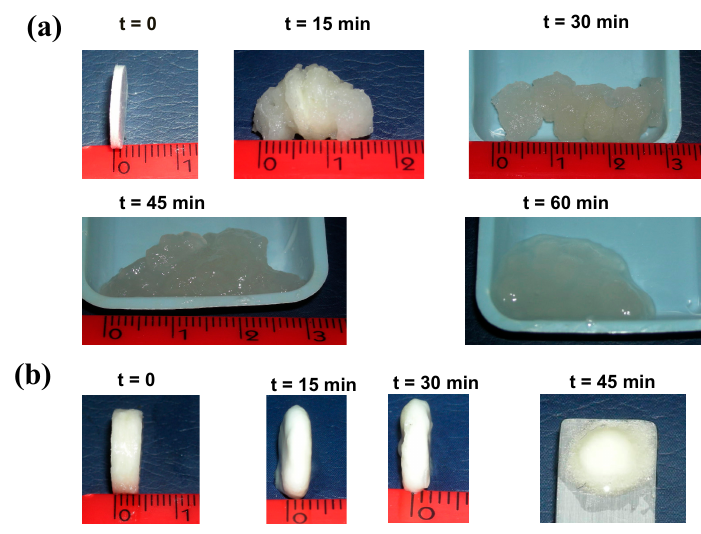
Figure 3. Pictures of Sclg/borax tablets, prepared in water and swelled in NaOH (pH = 14) ( a ) or prepared in NaOH (pH = 14) and swelled in water ( b ), after swelling, for different periods of time, at 37 °C.